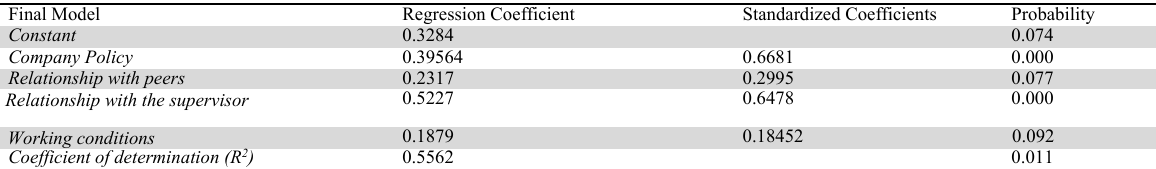
Coefficients of the final model (Normative commitment)